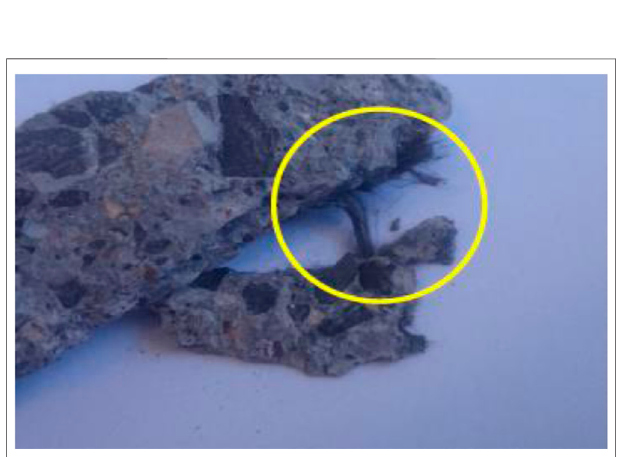
FIGURE 13 | Bridging effect of discard carbon fi bers in